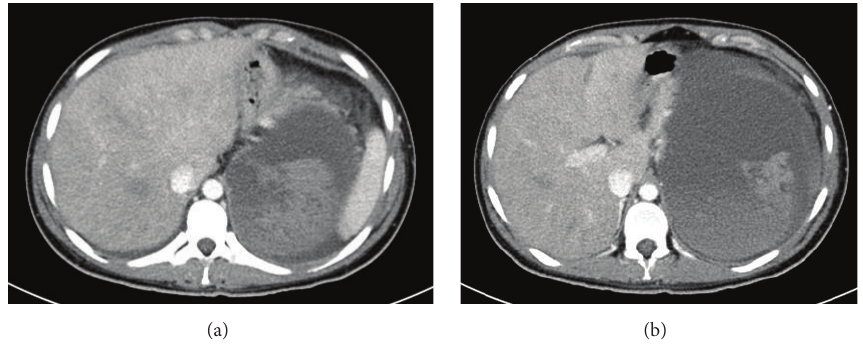
Figure 1: CT abdomen with contrast showing massive retroperitoneal haematoma of different ages.